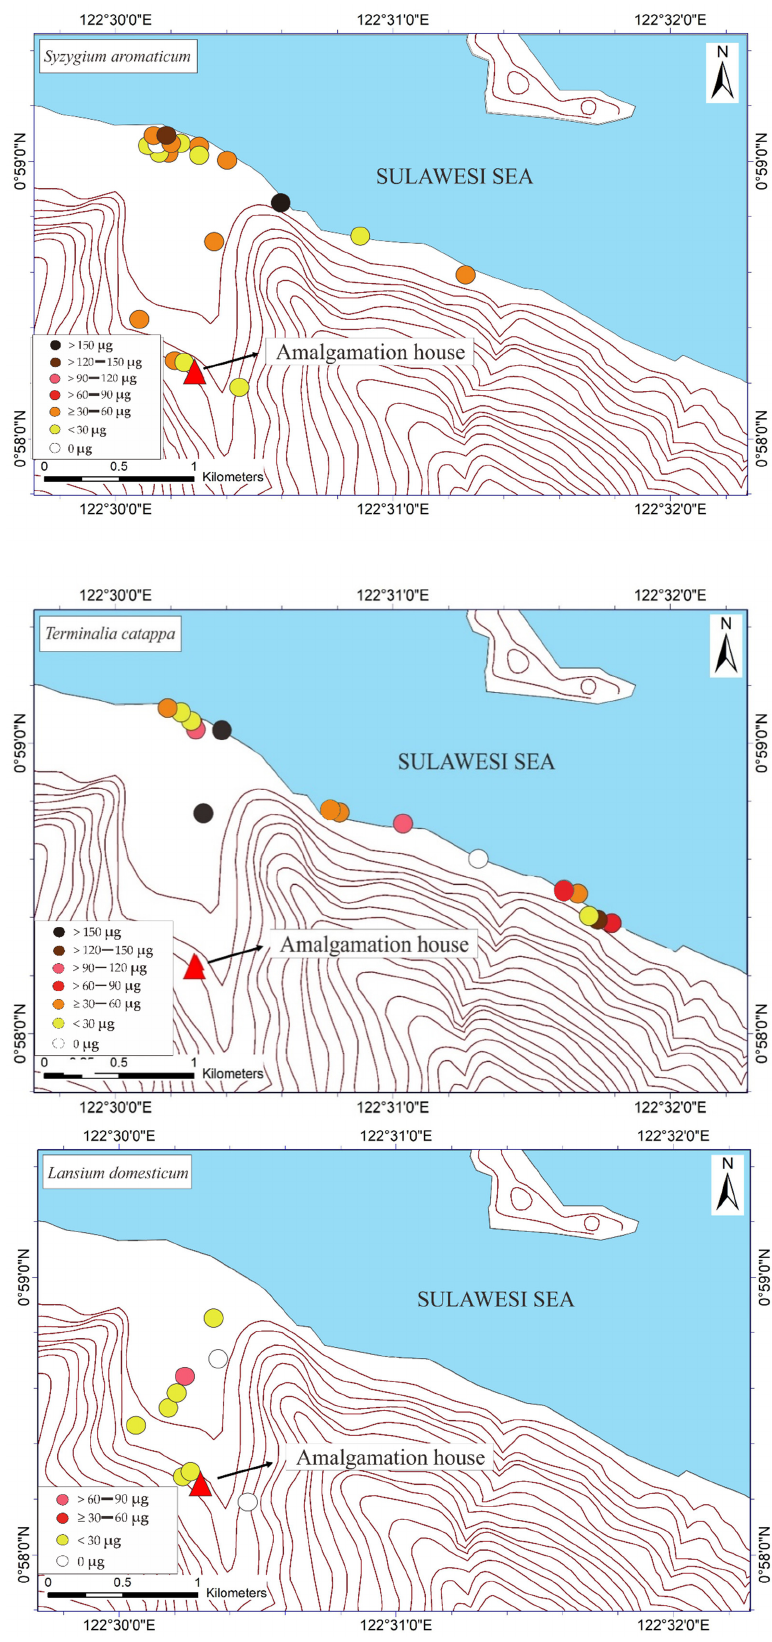
Figure 3. Mapped distribution of total weight of Hg (THg) in the bark of Mangifera indica , Syzygium aromaticum , Terminalia catappa , and Lansium domesticum ( N = 65). Table 1. Total weight of Hg (THg) in the bark and diameter of Mangifera indica.